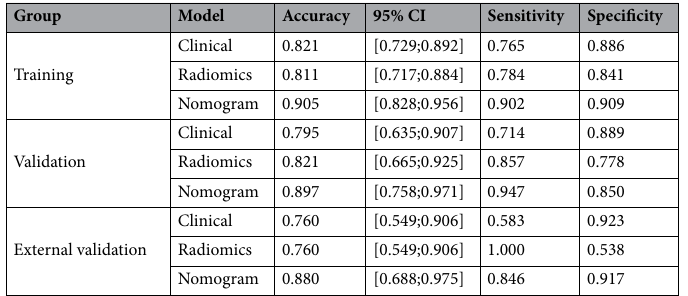
Table 3. Predictive performance outcomes of the radiomic nomogram, radiomic algorithm, and clinical